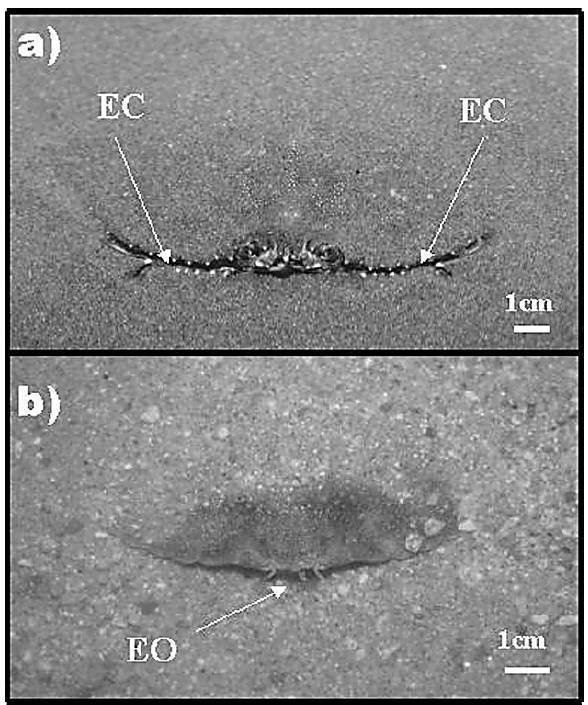
F IG . 1. – Photograph showing burial in the sand for a) Cancer mag- ister and b) Cancer productus . In C. magister the exostegal chan- nels (EC) are visible. C. productus shows the typical burial depth of this species, with the mouthparts, antennae and exhalant openings (EO) visible above the surface.